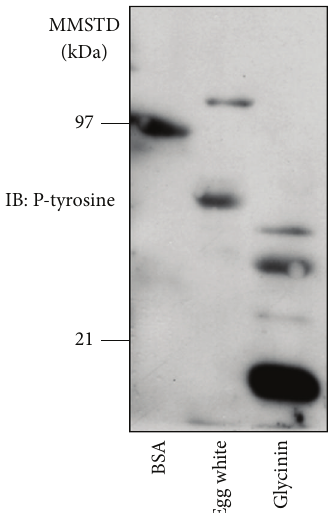
Figure 2: Identification of phosphorylated tyrosine in soy glycinin. Bovineserumalbumin,eggwhite,andsoyglycininweresubjectedto immunoblot analysis for phosphorylated tyrosine. MMSTD: molec- ular mass standards. Representative findings of three experiments with matching